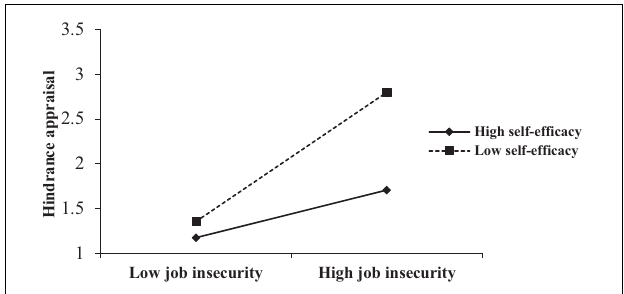
FIGURE 2 | The moderating effect of self-efficacy on the relationship between job insecurity and hindrance appraisal of job insecurity.